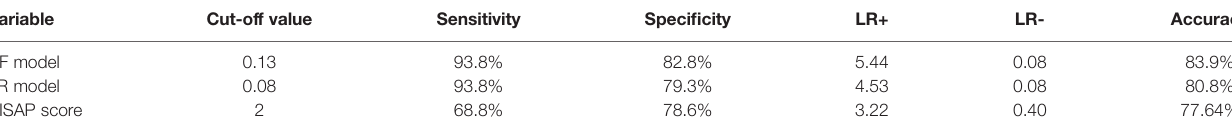
LR+, Positive likelihood ratio; LR-, negative likelihood ratio.